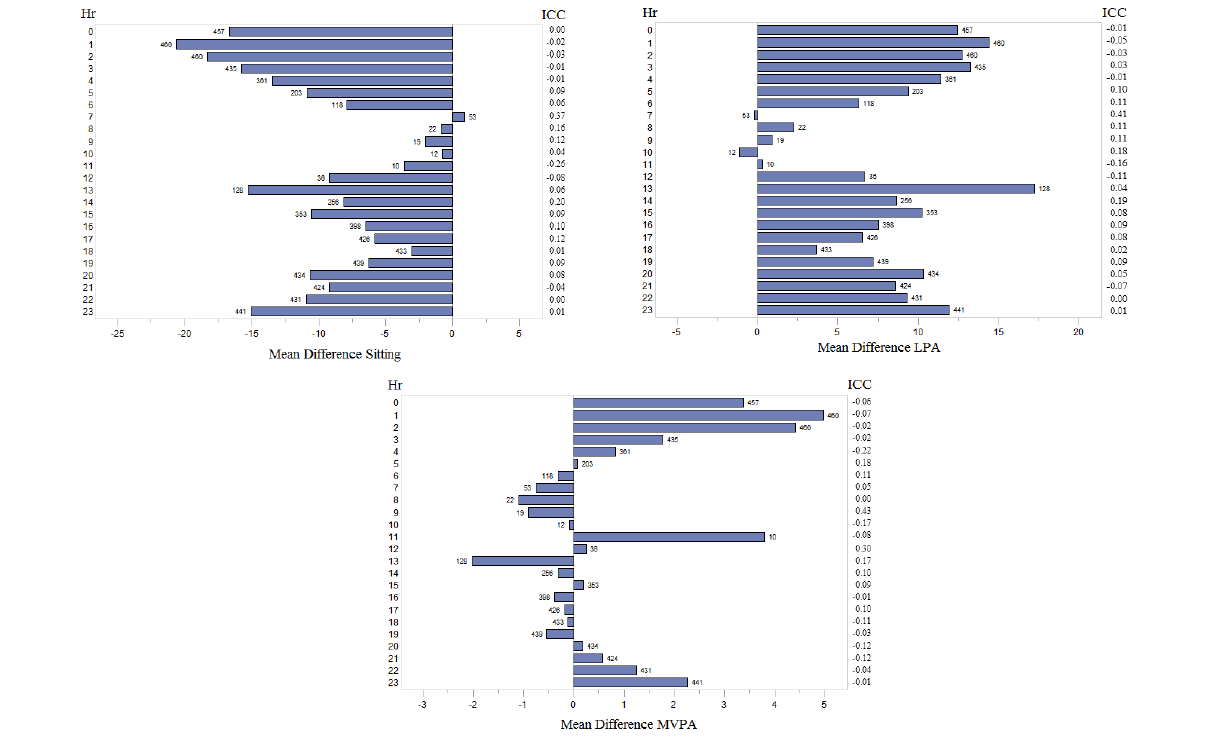
Figure 6. Hourly variability in accuracy of self-reported behavior among participants. The number of observations in each hour is presented beside each bar. Sleep time has been excluded from all analyses. LPA: light-intensity physical activity; MVPA: moderate-vigorous physical activity; ICC: intraclass